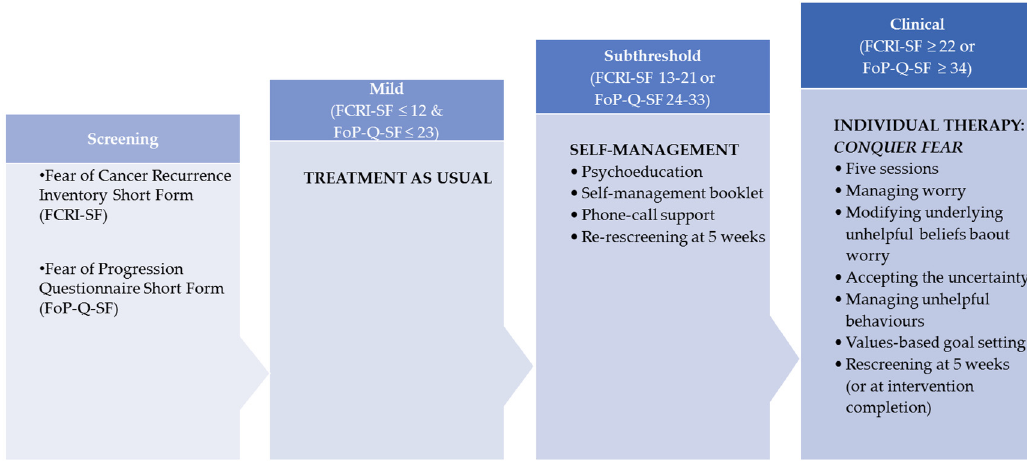
Figure 1. Stepped-care interventions.